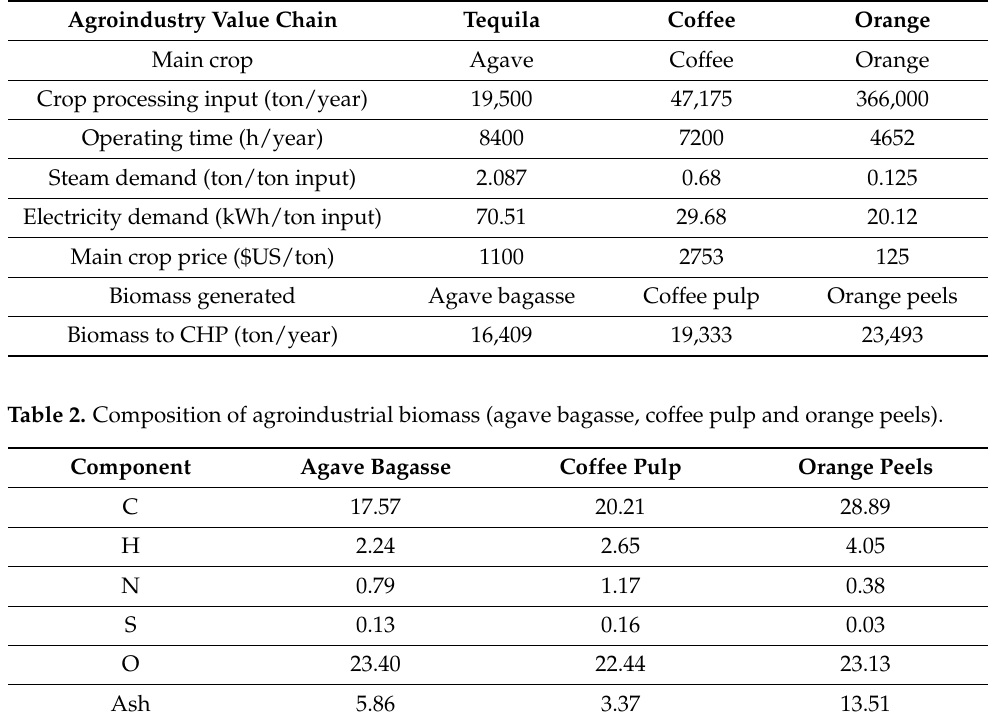
Figure 3. Overview of the main inputs and outputs in the agroindustrial processes for: ( a ) Tequila production, ( b ) coffee production and ( c ) orange juice production. Table 1. Agroindustrial operating parameters for agave, coffee and orange processing.